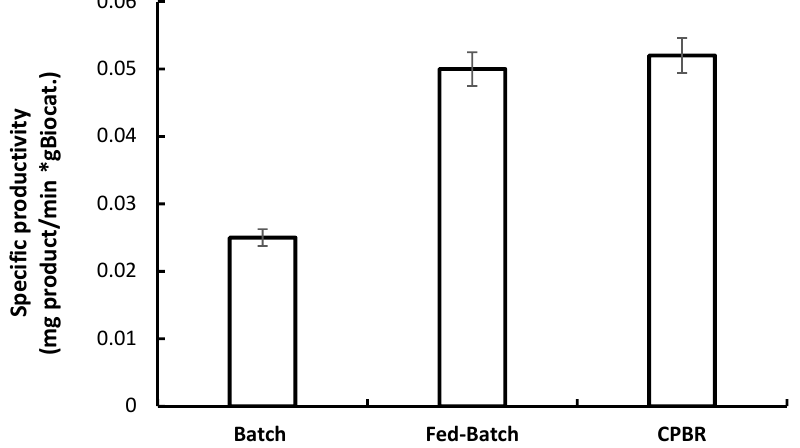
vation by the presence of H 2 O 2 and peracid.